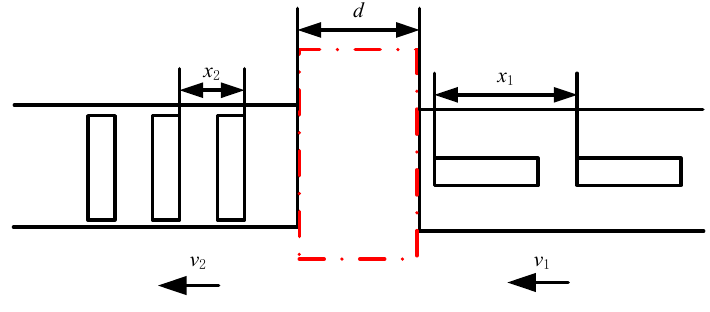
Figure 9. Production line working diagram.